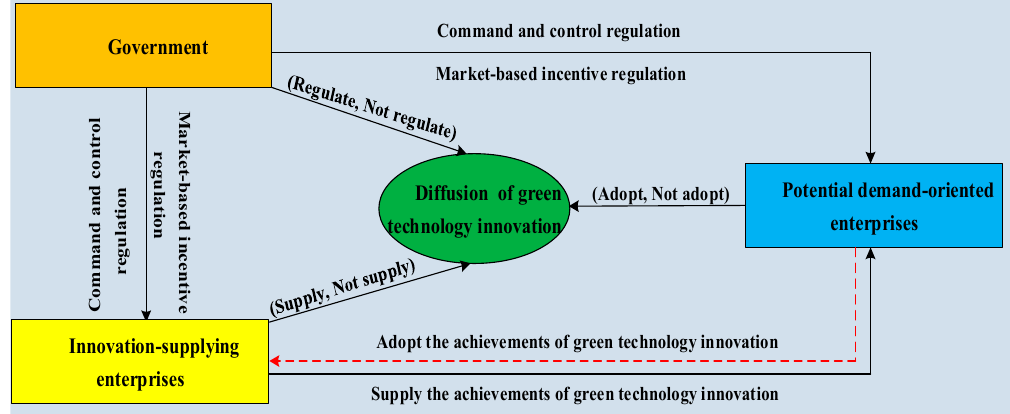
Figure 1. Illustration of the game relationships among the government, innovation-supplying enterprises, and potential demand-oriented enterprises.